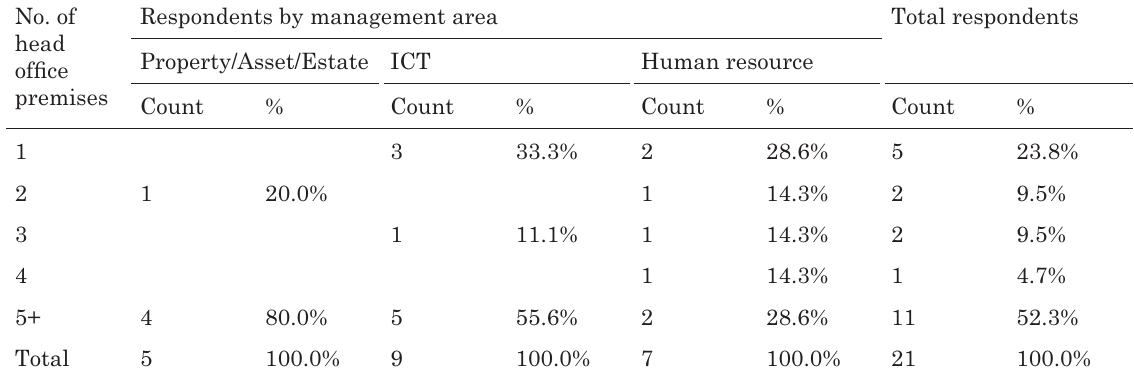
Table 1. Number of head offi ces No.